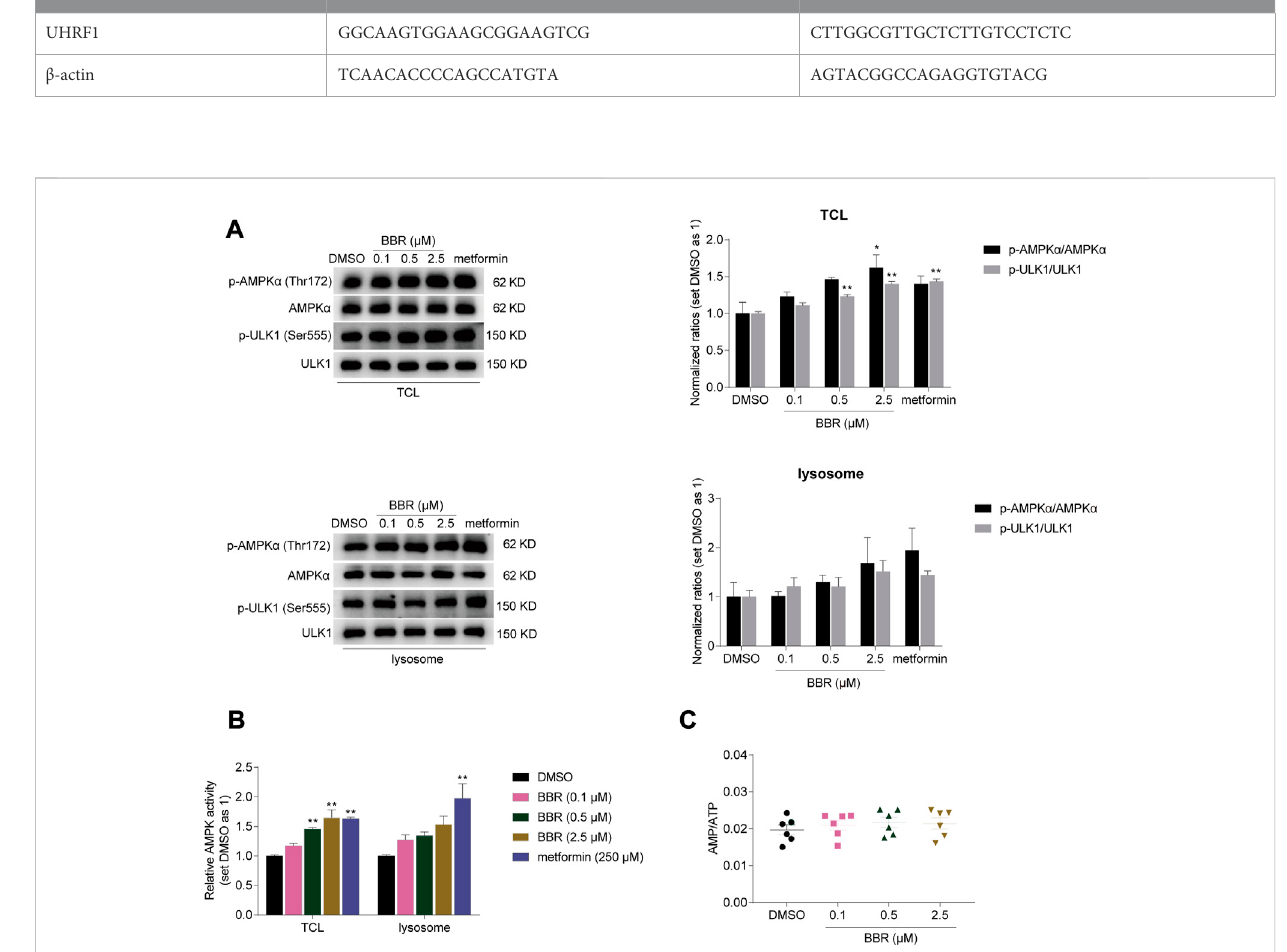
BBRactivatedlysosomalAMPK atthelow doses.BBRincreased phosphorylation ofAMPK α andULK1 (A) ,andsimulated AMPK activity (B) intotalcell lysates (TCL) and lysosomes of HCT-116 cells. BBR did not increase cellular AMP/ATP ratio at low doses (C) . Cells were treated with DMSO, BBR (0.1,